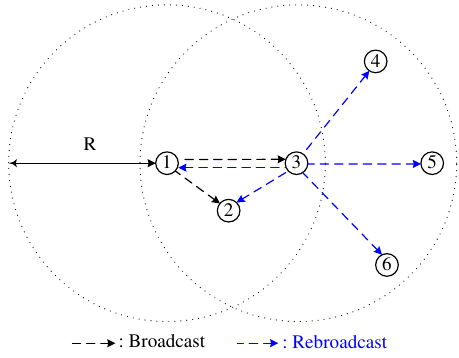
Figure 1. Distance-aware counter-based broadcast